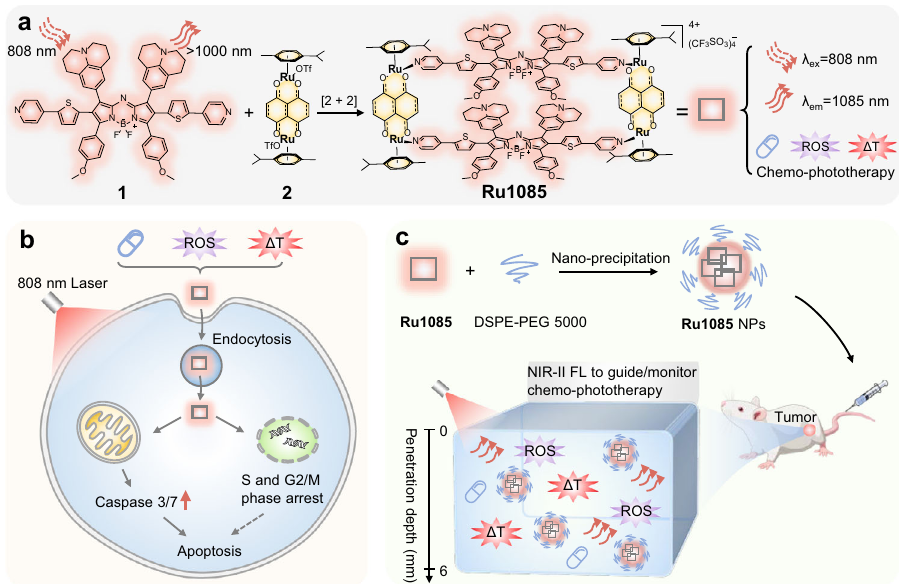
Fig. 1 Schematic illustration of the design, antitumor mechanism, and in vivo application of Ru1085. a The design, chemical structure, and properties of Ru1085, which is excited at 808 nm and emitted over 1000 nm with chemotherapeutic, photodynamic/photothermal properties. b The underlying antitumor mechanism illustrates the internalization of Ru1085 into A549 cells through endocytic pathway, and subsequently induces mitochondria- mediated apoptosis and arrested cell cycle at S and G2/M phase. c Ru1085 is utilized in NIR-II fl uorescence imaging for guiding and monitoring chemo- phototherapy in tumor-bearing mice